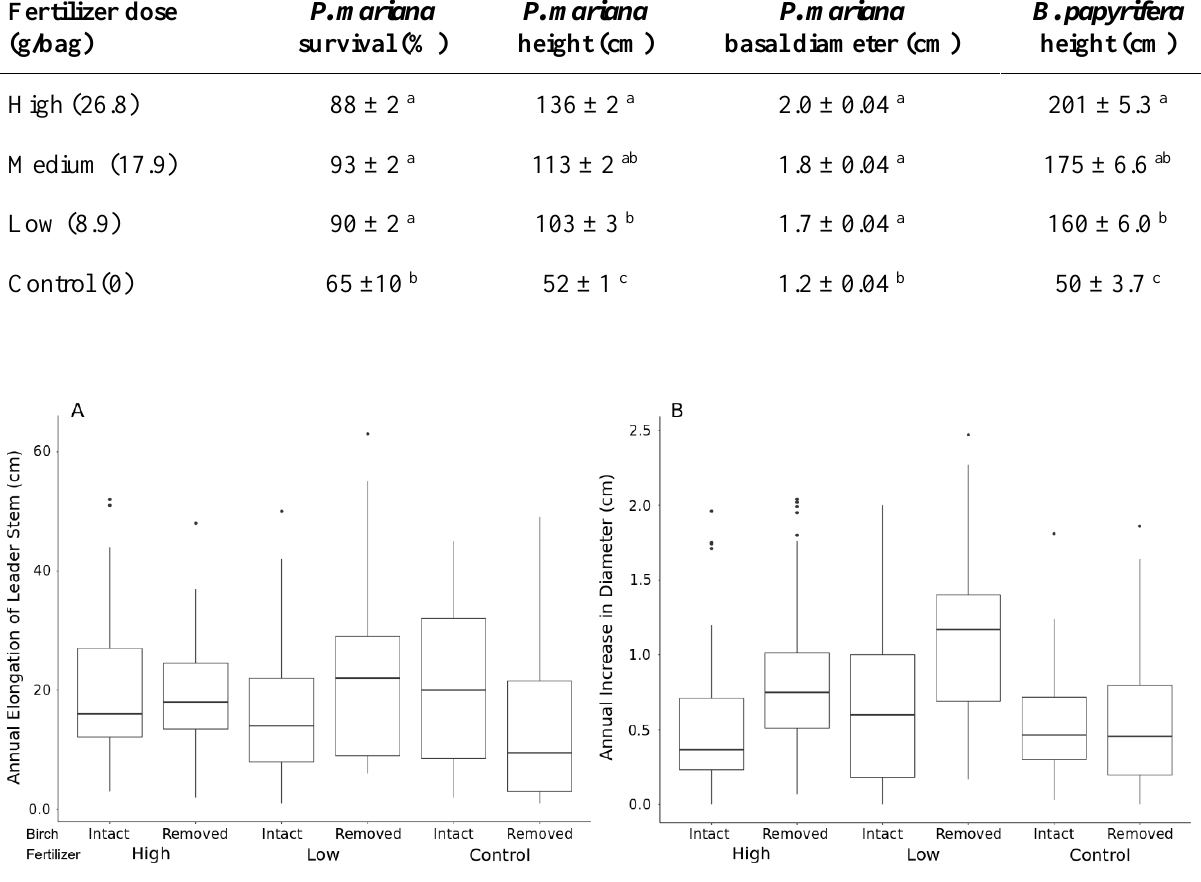
Figure 2. Annual elongation of leader stem (A) and increase in basal diameter of P. mariana (B) as a function of doses of fertilizer within plots where B. papyrifera were removed or left intact. The line in the middle of each box represents the median, the edges of the box the 25 th and 75 th percentiles, and the error bars 95 % of the data. There was a significant interaction effect between annual elongation of P. mariana leader stem with fertilizer treatment and birch removal (p < 0.001), such that the presence of intact birch trees within no- fertilizer controls did not reduce the growth of P. mariana compared to higher fertilizer doses. Increase in basal diameter was significantly less for P. mariana adjacent to intact B. papyrifera